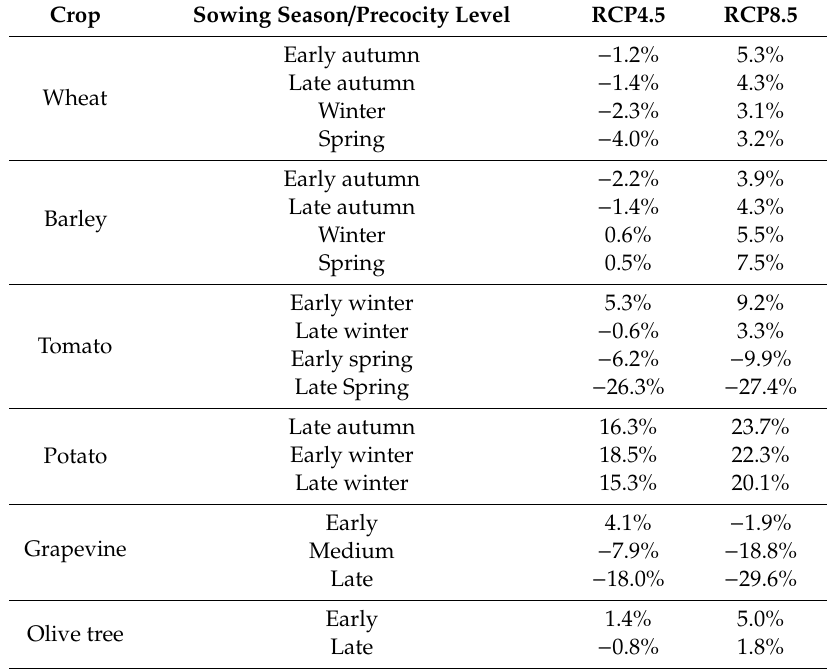
Table 8. Average crop yield response under di ff erent sowing seasons, precocity levels and future climate scenarios for Cyprus. RCP, representative concentration